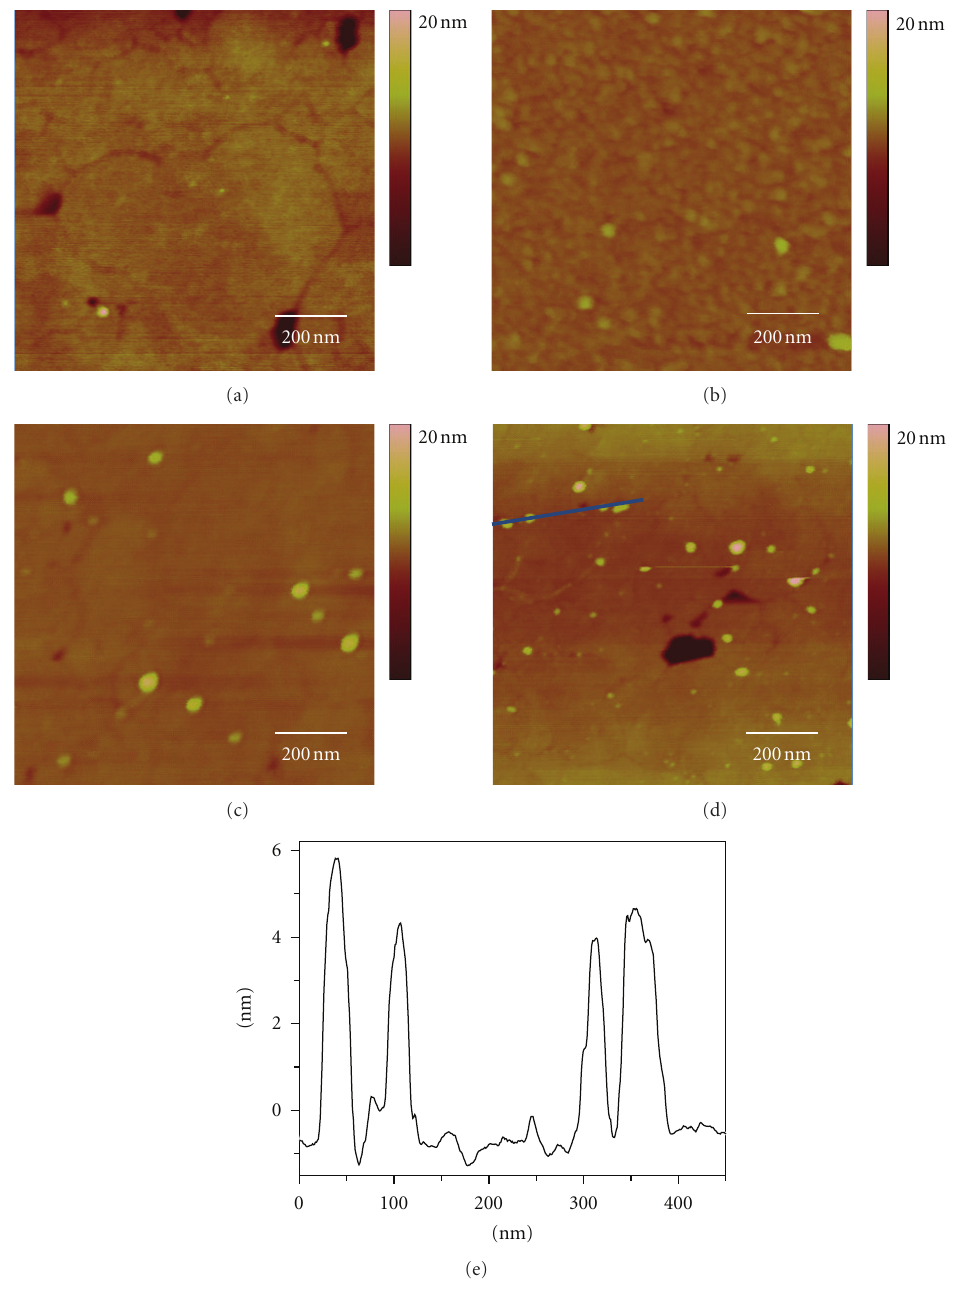
Figure 2: Representative SPM images of capture surface (1 × 1 μ m) of di ff erent concentrations of bound biotinylated G4 PAMAM dendrimers to avidin capture substrate: (a) blank and (b) 7 . 0 × 10 − 3 μ mol/L, (c) 7 . 0 × 10 − 2 μ mol/L, and (d) 3 . 28 × 10 − 1 μ mol/L; (e) a cross-sectional analysis of captured biotinylated G4 PAMAM dendrimers in